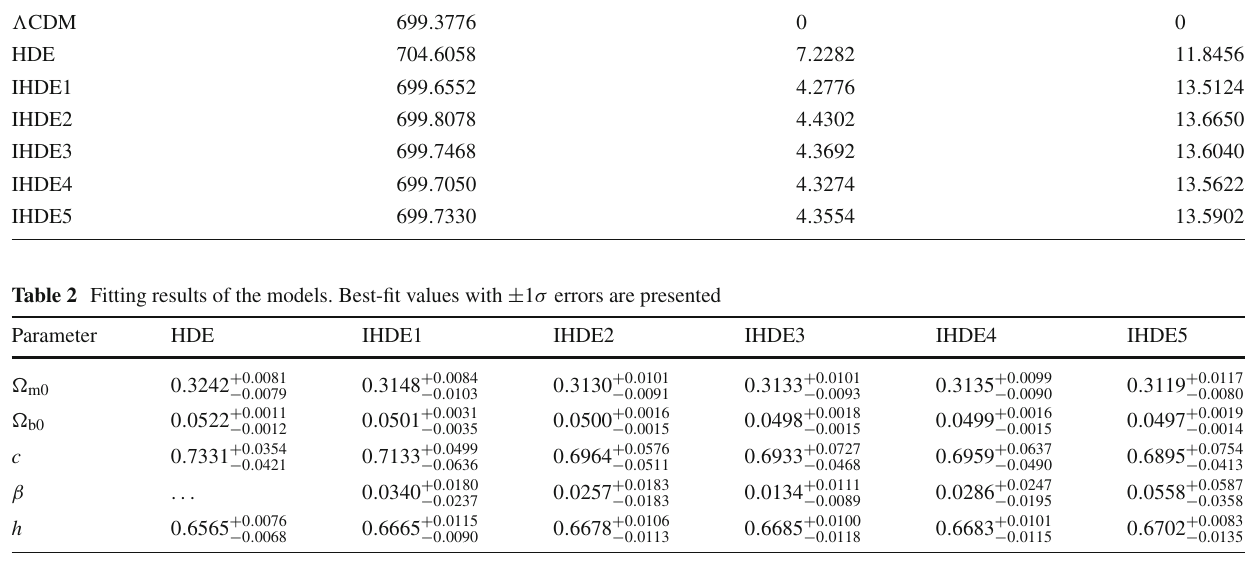
Table 1 Summary of the information criteria results Model